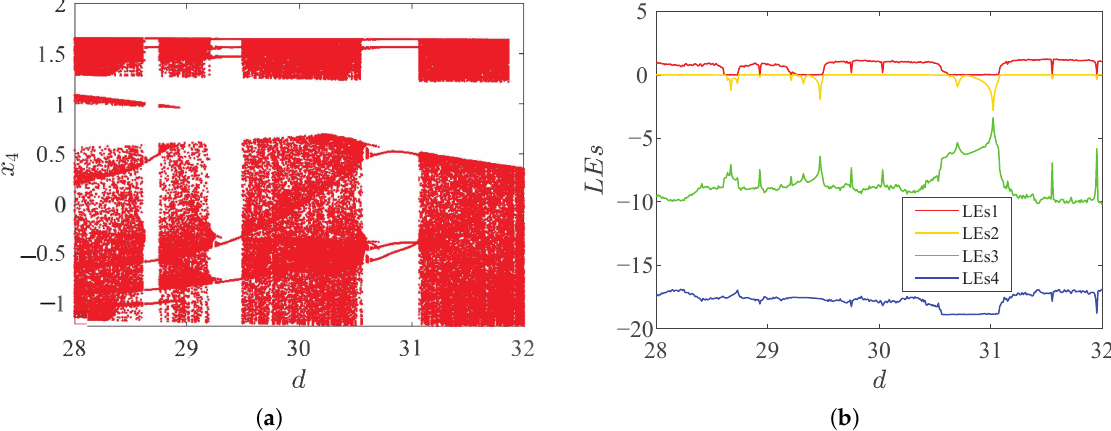
Figure 8. Dynamical behaviors with different parameter d of system (15). ( a ) Bifurcation diagram; ( b ) LEs.